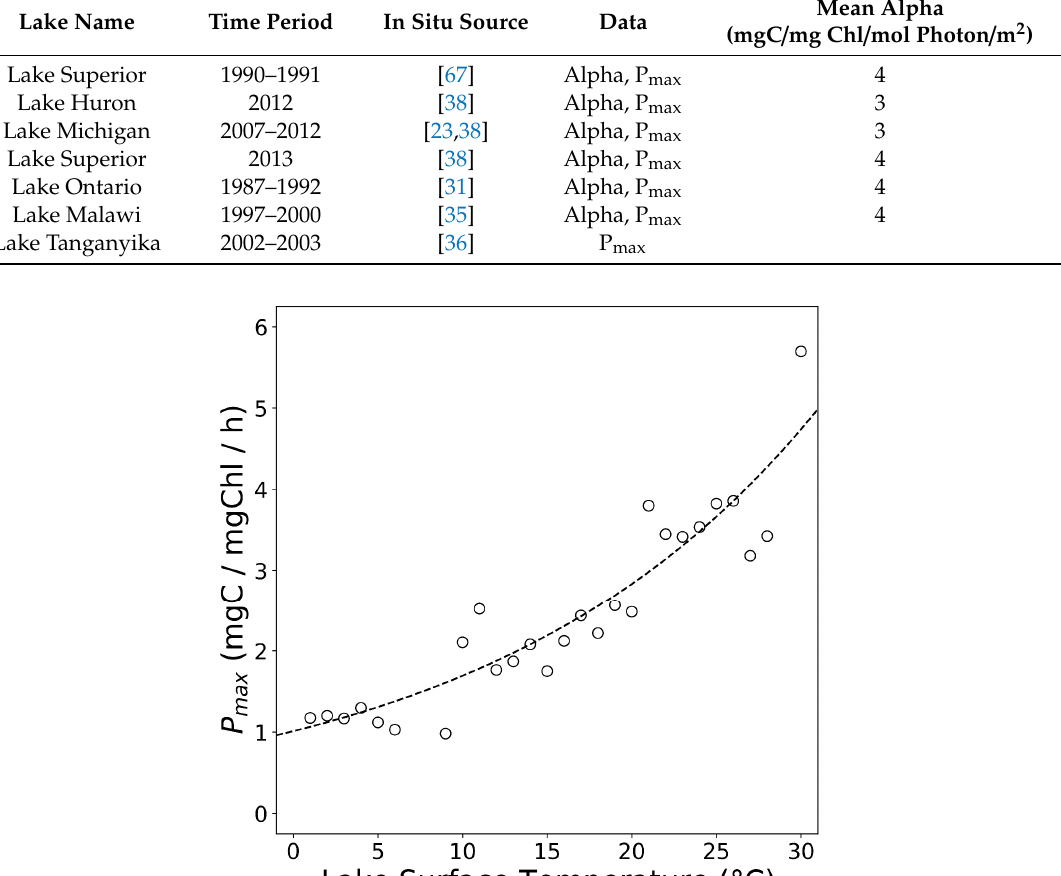
Table 3. Sources for historic alpha and P max data. The mean alpha value from each study is also included, rounded to the nearest integer.